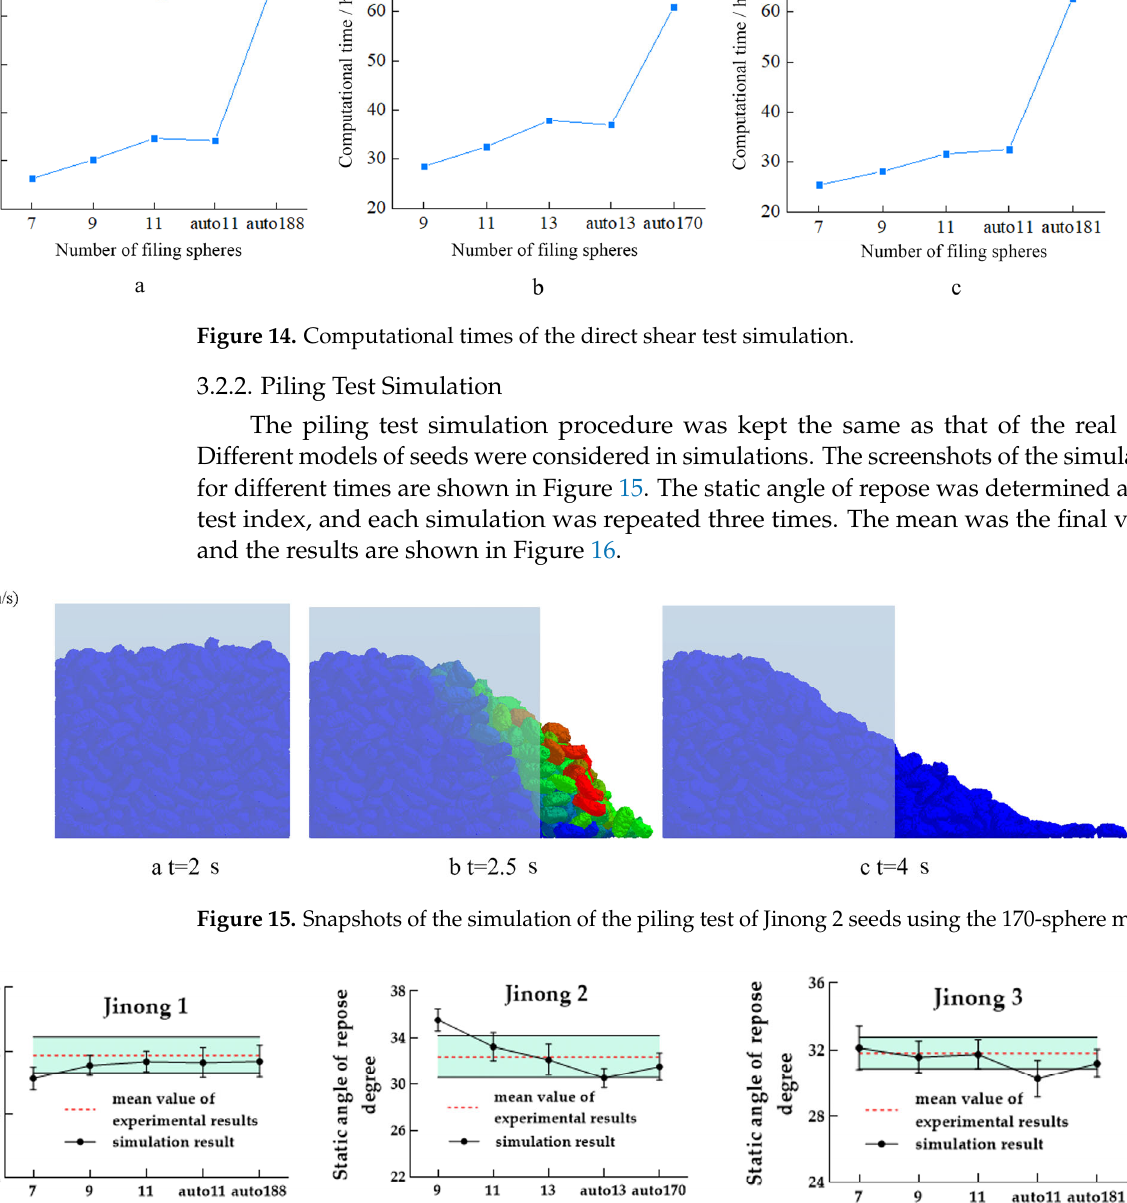
Figure 13. Simulation results of the direct shear test.